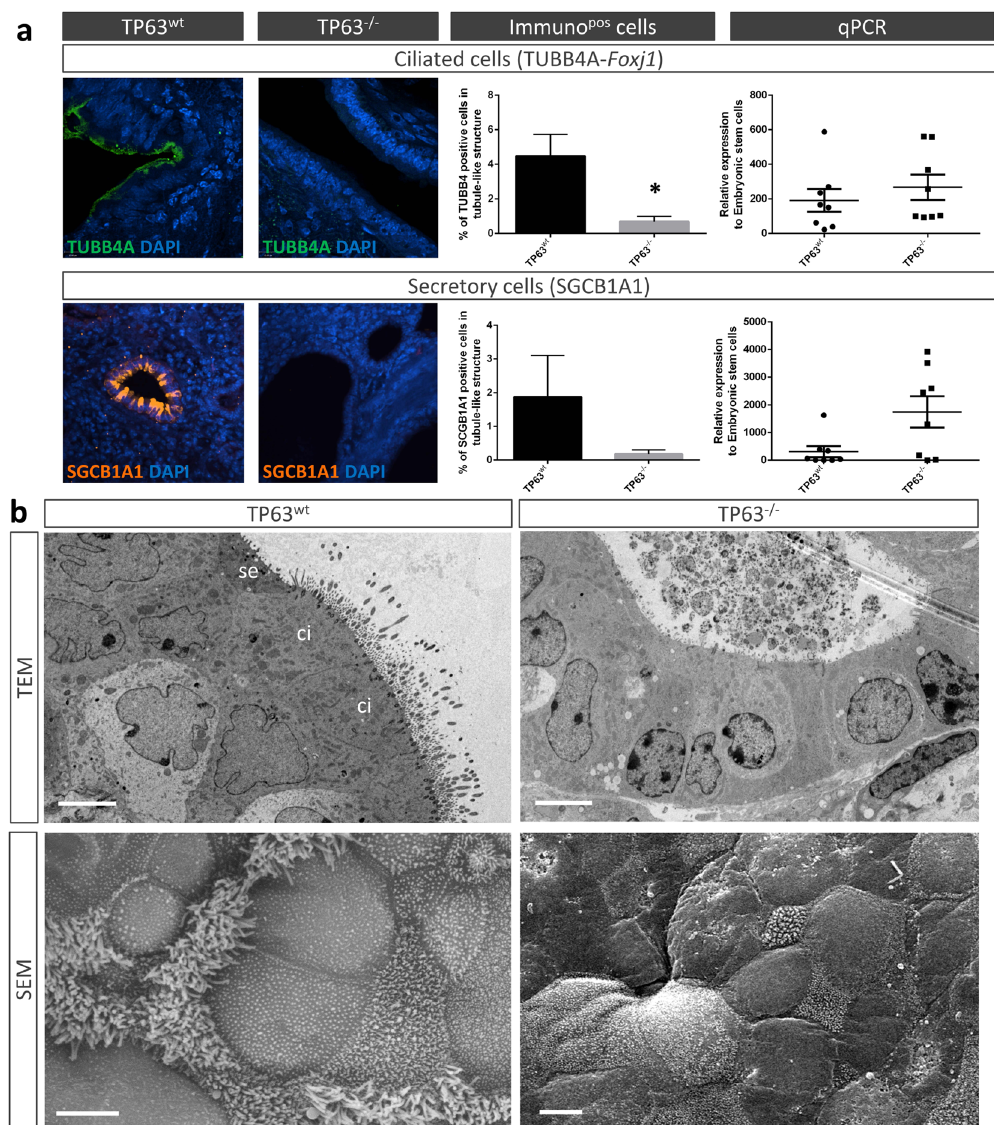
Fig. 5 TP63-de fi cient de fi nitive endoderm (DE) cells seeded on decellularized lung scaffolds do not differentiate into proximal airway cells. a- left panel Representative immuno fl uorescence confocal images and quanti fi cation of TUBB4A + and SCGB1A1 + epithelial cells in tubule-like structures after 21 days of culture (mean ± SEM, n ≥ 16 different scaffolds, * p < 0.05). a -right panel Quantitative PCR of Foxj1 and Scgb1a1 gene expression in wildtype vs TP63 − / − DE cell-scaffold cultures (mean ± SEM, n = 8 separate scaffold cultures). b Representative TEM and SEM images of wildtype vs TP63 − / − DE cell-scaffolds after 21 days of culture ( n = 3 separate scaffold cultures). se, secretory cell; ci, ciliated cell. Scale bar: 5 μ observation of most TP63 + basal cells being positive for KRT5 as bound to heparan sulfate proteoglycans on the lung scaffold drive the differentiation of endoderm cells to proximal airway cells 8 . Additionally, interactions between integrin receptors on DE cells with scaffold extracellular matrix might change cell behavior and fate 52 . The contribution of these bound molecules and/or integrin adhesion complexes to basal cell fate remains to be investigated. In the present study, TP63 + /KRT5 + and TP63 + /KRT14 + cells arise after 7 days of culture. In the adult lung, only a subset (~20%) of basal cells is positive for KRT14 27 , whereas in our decellularization-recellularization model the majority of basal cells expressing TP63 and KRT5 are also positive for KRT14. Both KRT14- negative and -positive subpopulations of basal cells in the adult lung upregulate their expression of KRT14 after injury 27,28 . In this context, all basal cells express KRT14 and these KRT14 + basal cells are direct progenitors for ciliated and club-like cells 28 . Our